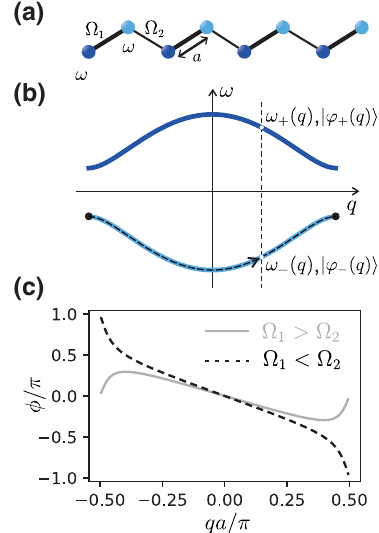
FIG. 6. (a) Chain with alternating dipole-dipole couplings forming the geometry of the Su-Schrieffer-Heeger model. (b) Two distinct bands emerge, separated by a band gap 2 | (cid:9) 1 − (cid:9) 2 | and with shape independent of the relation (cid:9) 1 ≶ (cid:9) 2 . The vertical dashed line shows the corresponding energies and eigenvectors corresponding to a given parameter q . The arrow in the lower band shows the path chosen for the integration to derive the accu- mulated phase from one end to the other one of the first Brillouin zone. (c) The accumulated phase on the lower energy branch shows considerable differences between the case of (cid:9) 1 > (cid:9) 2 and that of (cid:9) 1 < (cid:9) 2